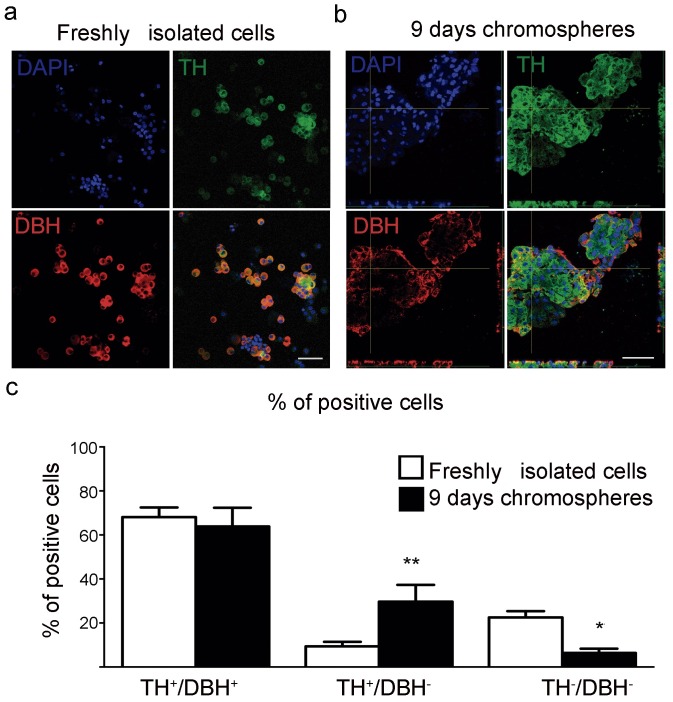
In vitro analysis of the number of TH+ cells in chromospheres and CC.(a-b) Confocal microscopy photographs showing double-immunofluorescence staining for TH (green, top right panel) and DBH (red, bottom left panel) in freshly isolated cells (a) and 9 days-chromospheres (b). Nuclei are marked with DAPI (blue, top left panel). Channels are shown separately and the merge of the three channels is shown at the bottom right panel. For chromosphere-slices (b) an orthogonal view is shown (xyz). Scale bar is 100 μm. (c) Percentages of the number of cells that expressed TH together with DBH (TH+/DBH+), TH only (TH+/DBH-), and cells only marked with DAPI (TH-/DBH-). The percentages were calculated relative to the total number of counted nuclei. Error bars are the SEM and the mean was obtained from three independent cultures with a total of six coverslips with fixed-freshly isolated cells or three slides with fixed-chromospheres sections. Statistically significant differences were observed for TH+/DBH- chromospheres cells (29.71 ± 7.635%) compared to freshly isolated cells (9.363 ± 2.083%) and for TH-/DBH- chromospheres (6.410 ± 1.937%) compared to freshly isolated cells (22.50 ± 2.9%) (multivariate ANOVA, P < 0.05; F = 71.21, DF = 2, p < 0.0001, followed by Bonferroni’s multiple comparisons post hoc test, p = 0.0057** for TH+/DBH- and 0.0128* for TH-/DBH-).